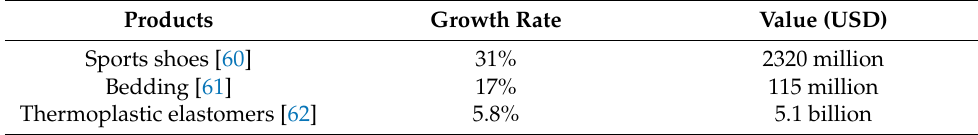
Table 3. Growth rate and value of market size of SME